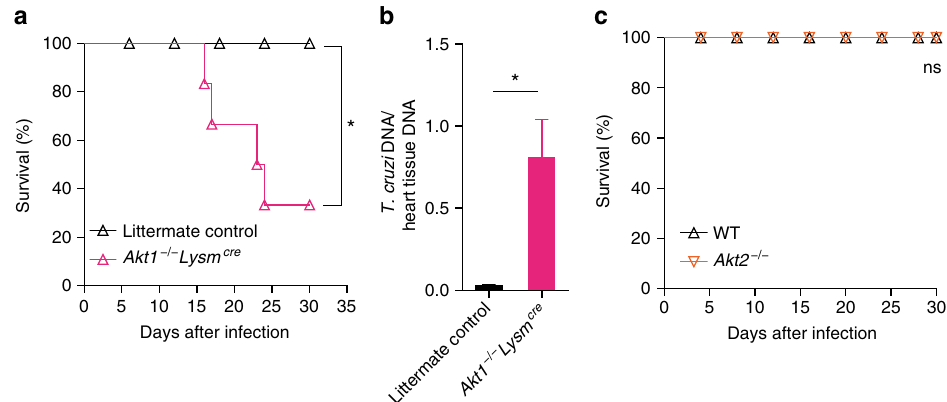
Fig. 8 AKT1 signaling in myeloid cells confers resistance to T . cruzi infection. a Survival rate of littermate control ( n = 7) and Akt1 − / − Lysm cre ( n = 7) mice after infection with 10 3 trypomastigote forms of T . cruzi Y strain. b Quantitative PCR analysis of picogram of T . cruzi DNA presents in 1 ng of heart tissue DNA isolated from WT ( n = 5) and Akt1 − / − Lysm cre ( n = 5) mice. c Survival rate of WT ( n = 7) and AKT2 − / − ( n = 7) mice infected with 10 3 trypomastigote forms of T . cruzi Y strain. * P < 0.05 and ns = no statistical signi fi cance (Mantel – Cox log-rank test in a , c and unpaired Student ’ s t -test in b ). Data are representative of two independent experiments (mean ± s.e.m in b